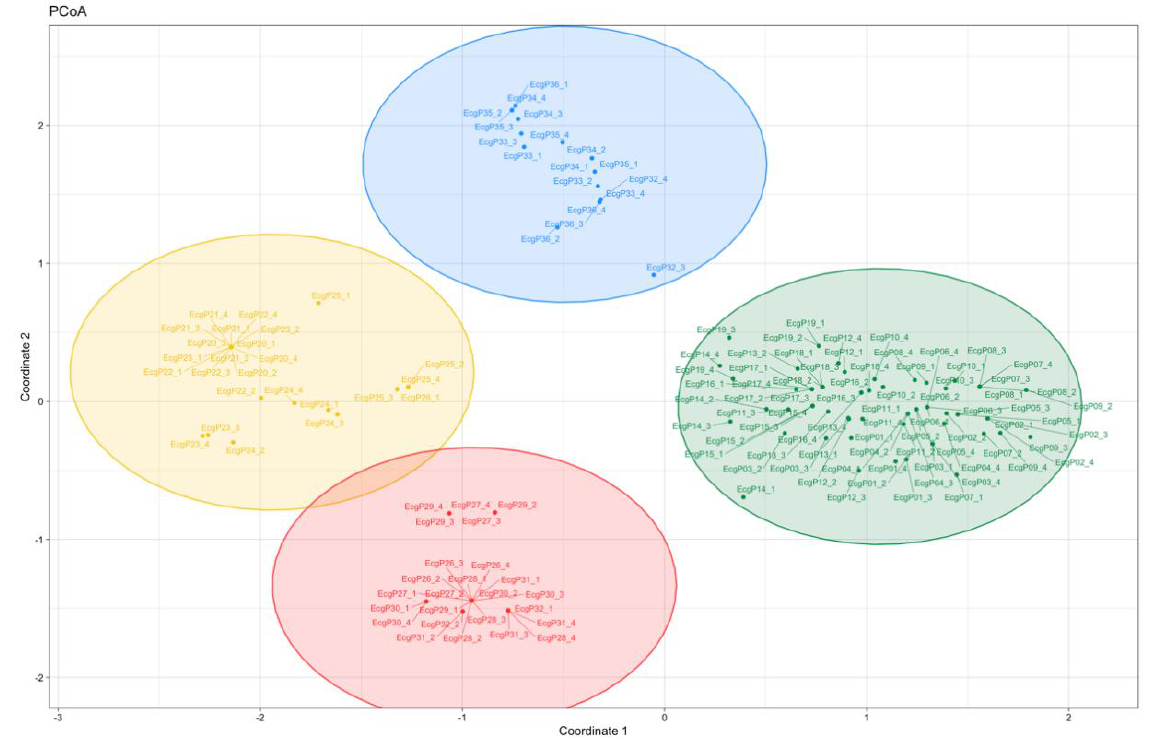
Figure 4. Principal Coordinates Analysis based on Simple Sequence Repeats in Echinochloa crus-galli . Groups red and yellow = specimens collected from experimental parcels where only pre-emergent weed control was applied. Groups blue and green = specimens collected from experimental parcels where conventional weed control was applied.